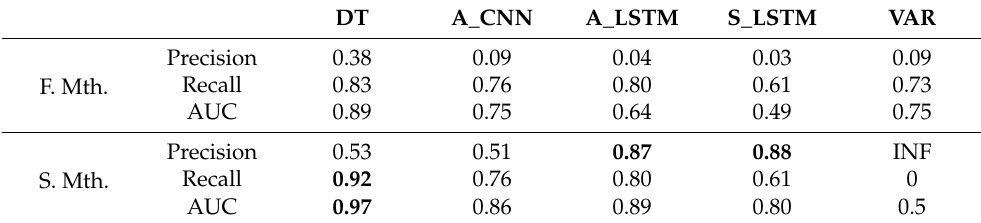
Table 6. Comparison results of between different algorithms (cells in bold report best scores).